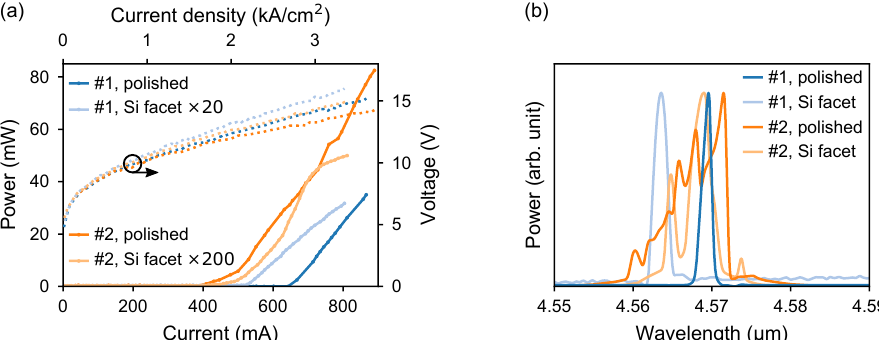
Figure 8. ( a ) LIV and ( b ) spectral characteristics of two DFB lasers, corresponding to emission from the hybrid III-V/Si facet after one taper was polished